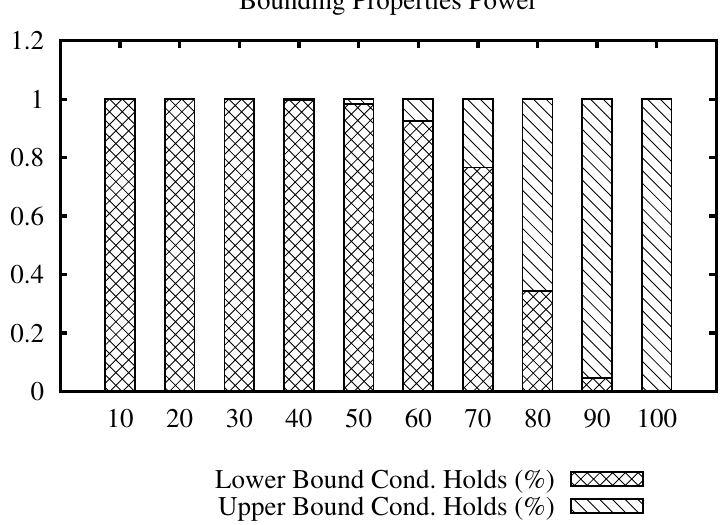
Figure 6. Percentage of filtering that each bounding property can achieve upon the range of radius of the join algorithm using the USCities data